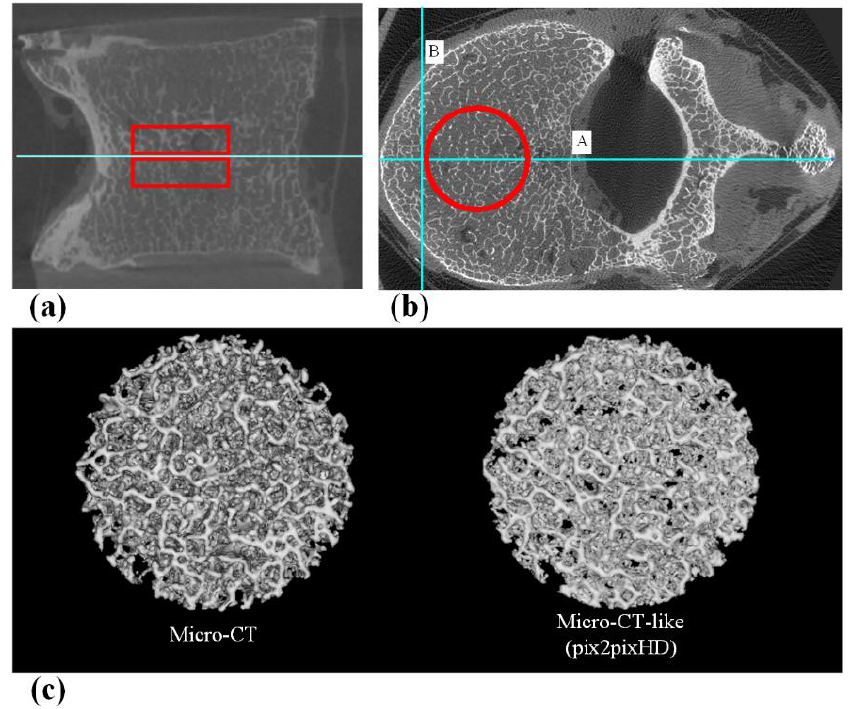
Figure 4. ( a ) The sagittal position of the VOI, which includes two areas 5 mm above and below the central slice. ( b ) The axial position of the VOI. First, the vertebral body central axis line A (Horizontal positioning line) was drawn, and then, line B (Vertical positioning line) was drawn perpendicular to line A at 5 mm inside the intersection of line A and the anterior edge of the vertebral body. Using the intersection of lines A and B as the tangent point, a cylindrical VOI with a diameter of 15 mm was outlined. ( c ) 3D reconstructed VOI of micro-CT and micro-CT-like images.